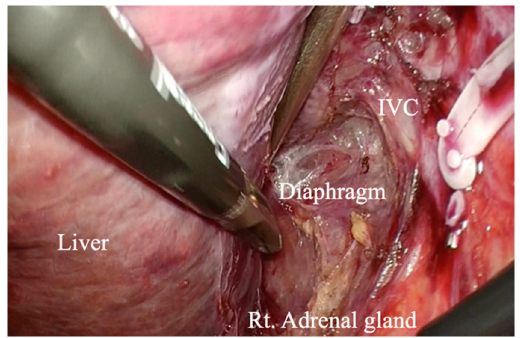
Figure 3. Intraoperative photo with a space created on the right side of the inferior vena cava. The right and the middle hepatic veins are exposed. A cholecystectomy is then per- formed. After the right Glissonean pedicle is taped, the right hepatic artery and right portal vein are clipped and dissected. The right hepatic duct is dissected when parenchymal transection is performed and sufficient space is secured. Parenchymal transection is per- formed along the demarcation line. The Pringle maneuver [12] is employed if